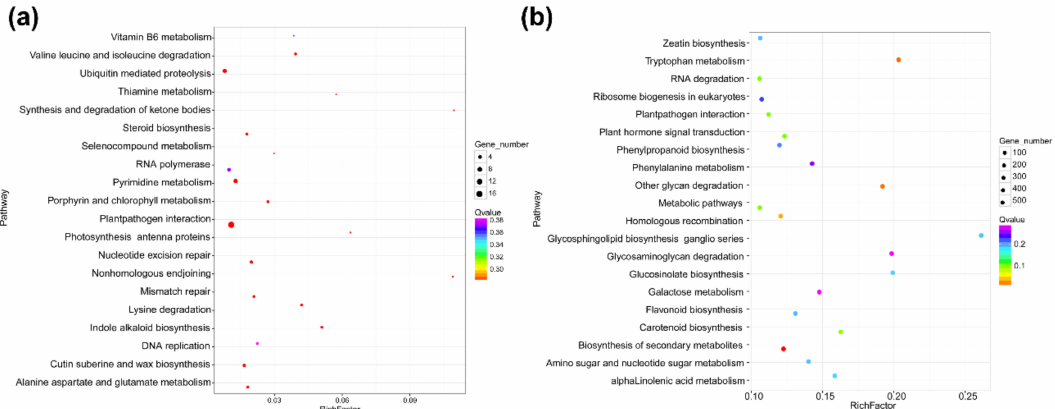
Figure 4. Statistics of the KEGG pathways enriched for mRNAs co-located with DElncRNAs ( a ) and mRNAs co-expressed with DElncRNAs ( b ). The size of each circle represents the number of significant DEmRNAs enriched in the corresponding pathway. The enrichment factor was calculated using the number of enriched DEmRNAs divided by the total number of background genes in the corresponding pathway. A pathway with a p -value < 0.05 is considered to be significantly